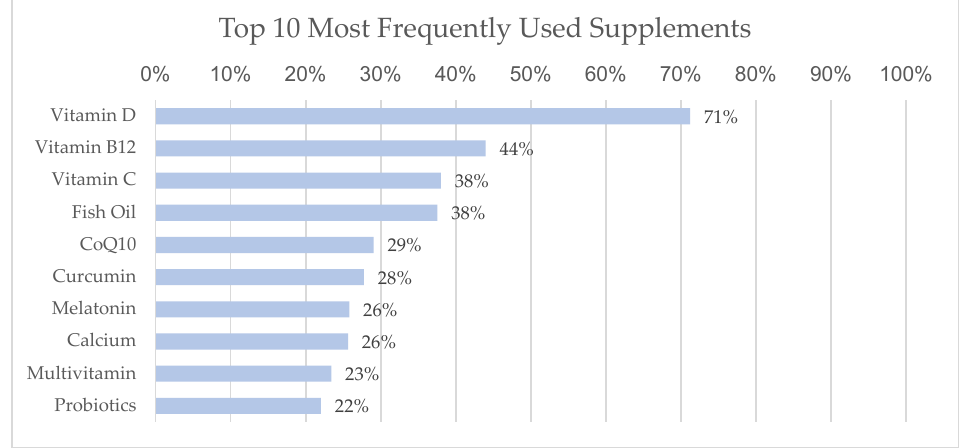
Figure 1. Ten most used supplements in this sample cohort with percentage of cohort using the supplement.